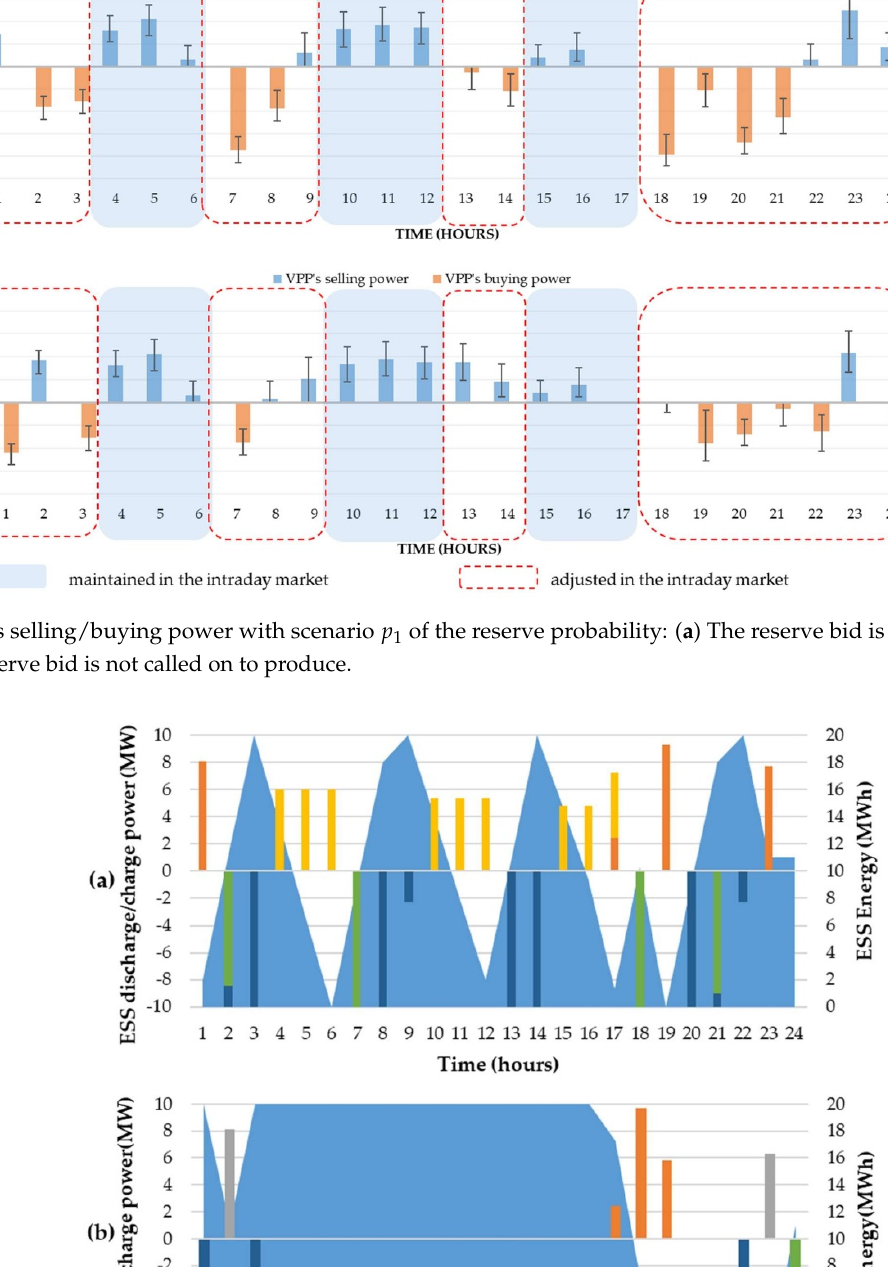
Figure 10. The RES operational scheduling with scenario 𝑝 (cid:2869) of the reserve probability: ( a ) The reserve bid is called on to produce; ( b ) the reserve bid is not called on to produce